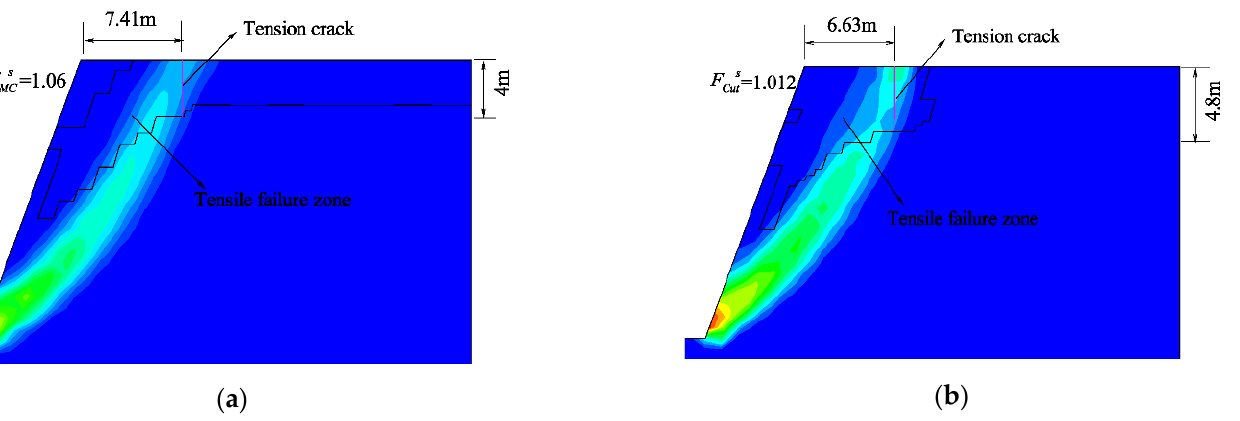
Figure 7. Comparisons of failure mechanisms with β = 70 ◦ . ( a ) failure mechanisms of intact M–C surface; ( b ) failure mechanisms of the cut-off M–C surface.